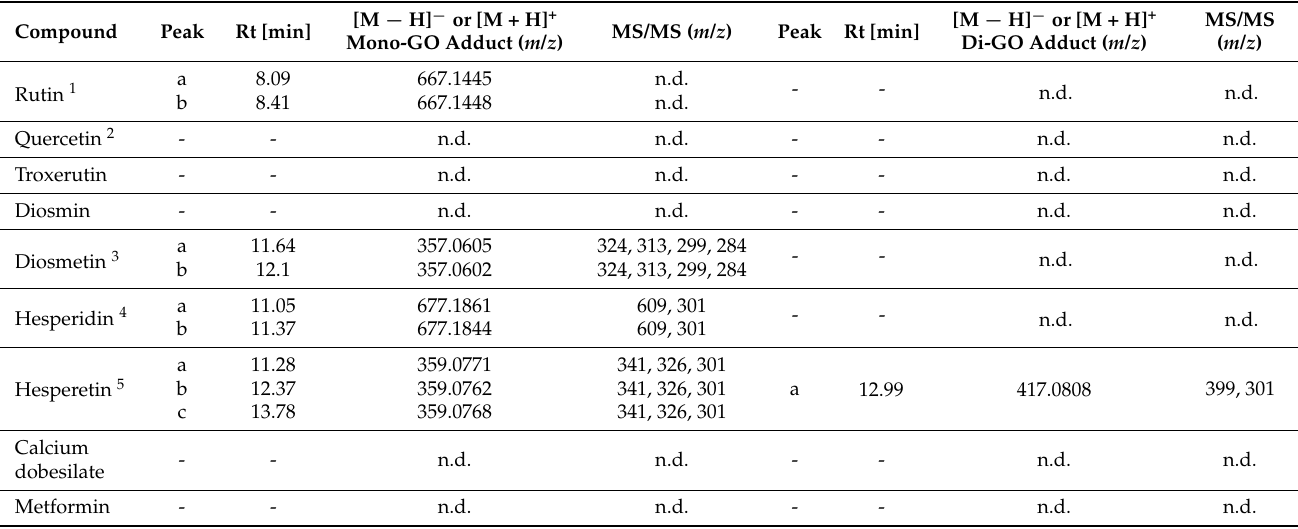
Table 3. Adducts of glyoxal and investigated compounds formed after 1 h of incubation in pH 7.4 phosphate buffer solution at 37 ◦ C.